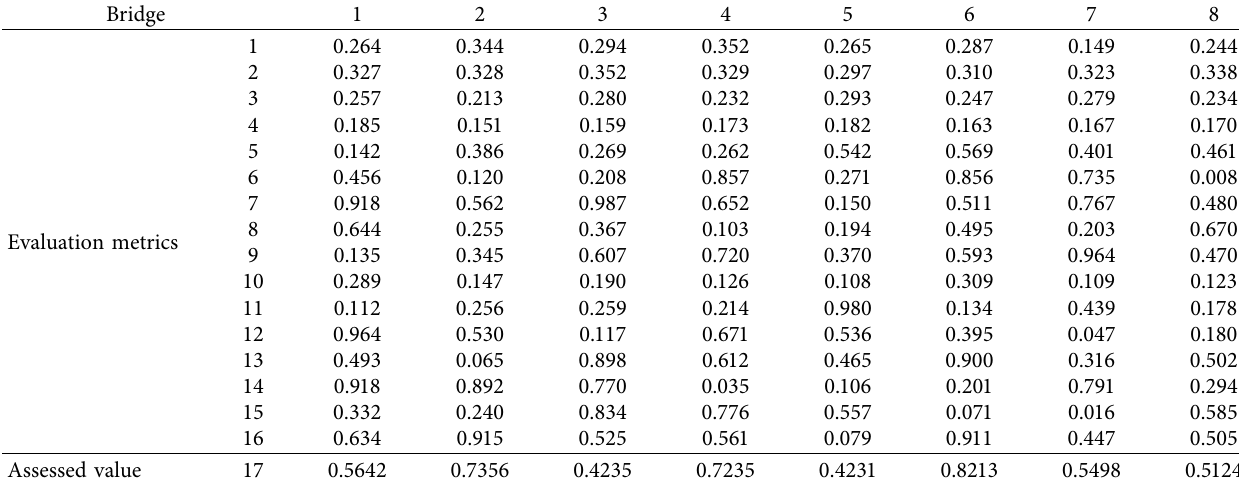
Table 5: Evaluation index data of preventive maintenance of highway